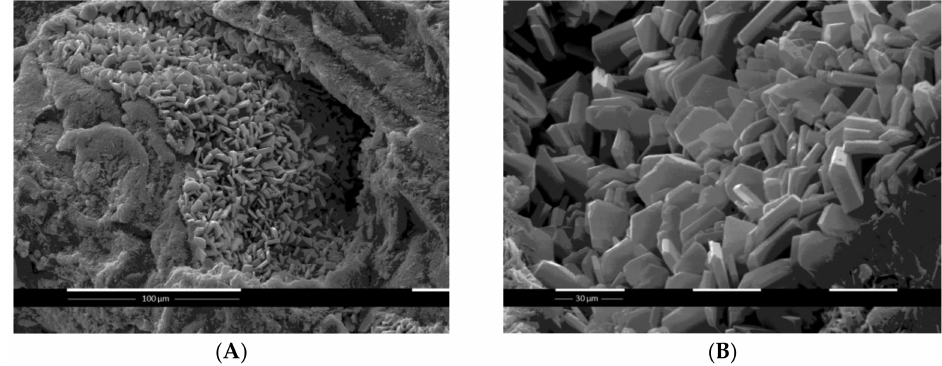
Figure 1. SEM images of druse of recrystallised clinoptilolite at magnification: ( A ) × 1000 and ( B ) ×